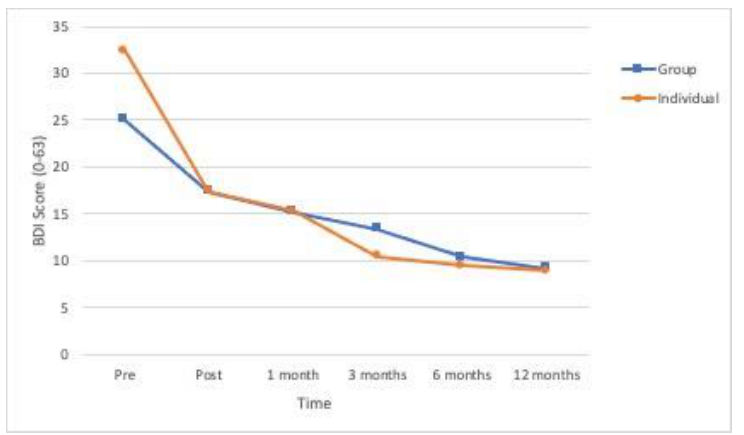
Figure 2. Evolution over time of the levels of posttraumatic symptoms (Severity of Posttraumatic Stress Disorder Symptoms Scale -EGS) in the two experimental conditions ( n = 53).